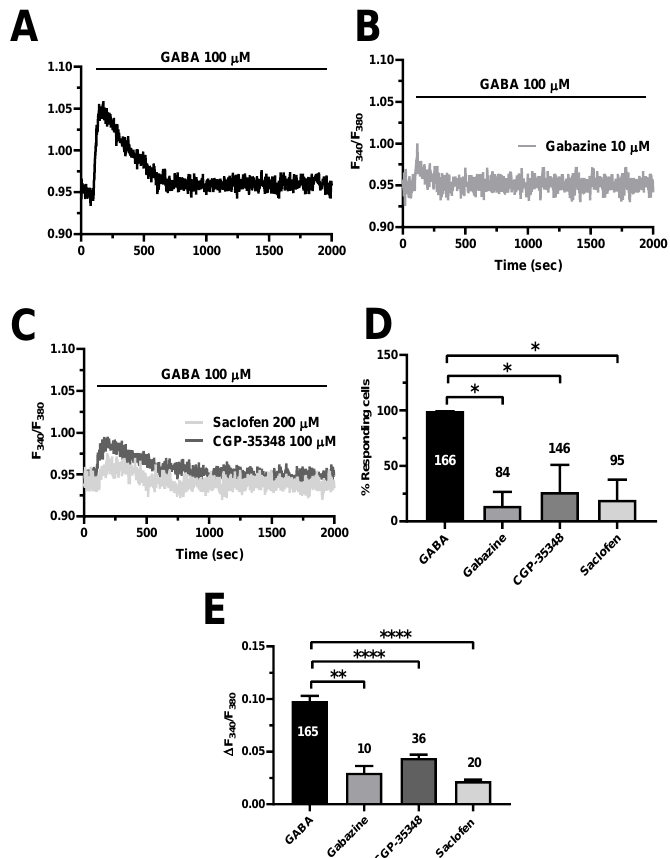
Figure 5. The pharmacological blockade of GABA A and GABA B receptors inhibit GABA-evoked intracellular Ca 2+ signals in hCMEC/D3 cells. ( A ), representative tracing of the Ca 2+ response induced by GABA (100 µ M) under control (Ctrl) conditions. ( B ), blocking GABA A receptors with gabazine (10 µ M, 5 min) significantly reduced GABA-evoked intracellular Ca 2+ signals. ( C ), blocking GABA B receptors with either saclofen (200 µ M, 5 min) or CGP-35348 (100 µ M, 5 min) significantly reduced GABA-evoked intracellular Ca 2+ signals. ( D ), mean ± SE of the percentage of hCMEC/D3 cells responding to GABA under the designated treatments. * indicates p < 0.05 (one-way ANOVA followed by the post-hoc Dunnett’s test). ( E ), mean ± SE of the amplitude of the peak Ca 2+ response to GABA under the designated treatments. **** indicates p < 0.0001, ** indicates p < 0.01 (one-way ANOVA followed by the post- hoc Dunnett’s test).